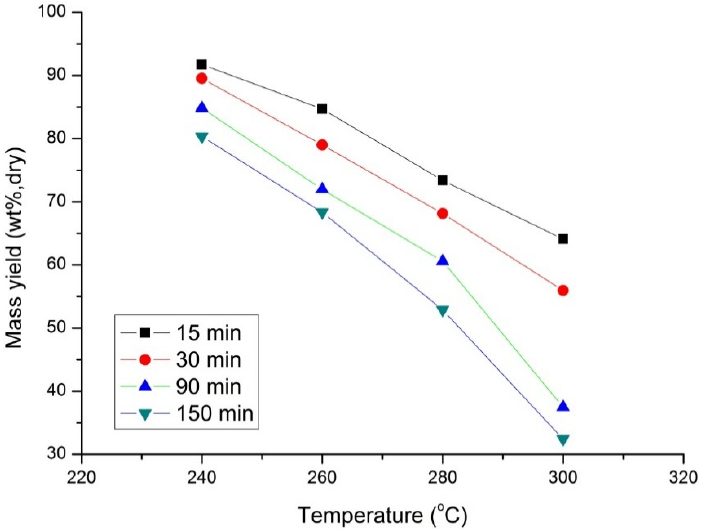
Figure 8. Mass yield of beech wood with temperature at four different torrefaction and residence times.